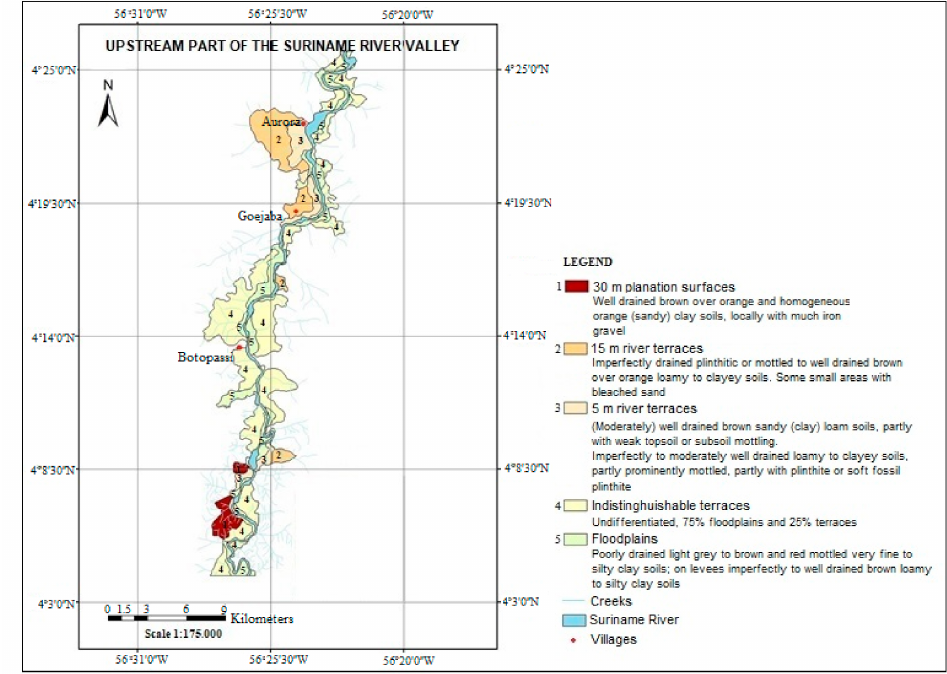
Figure 3. Map of terraces along the upstream river valley part of the Suriname